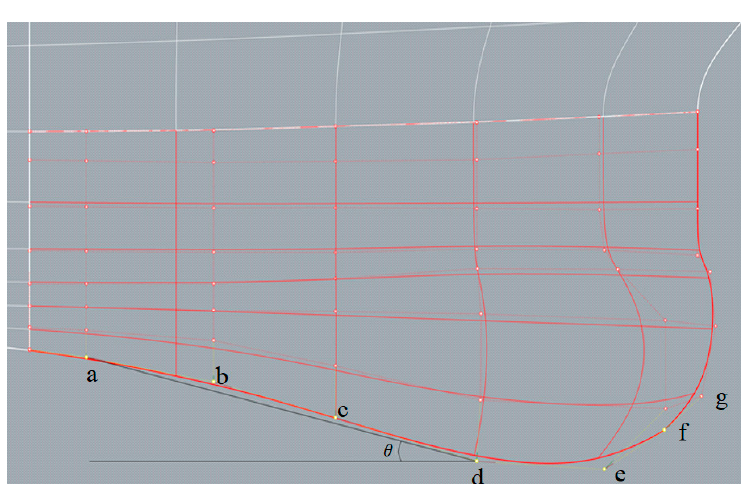
Figure 3. Control point a, b, c, d, e, f, g along the sonar dome bottom.